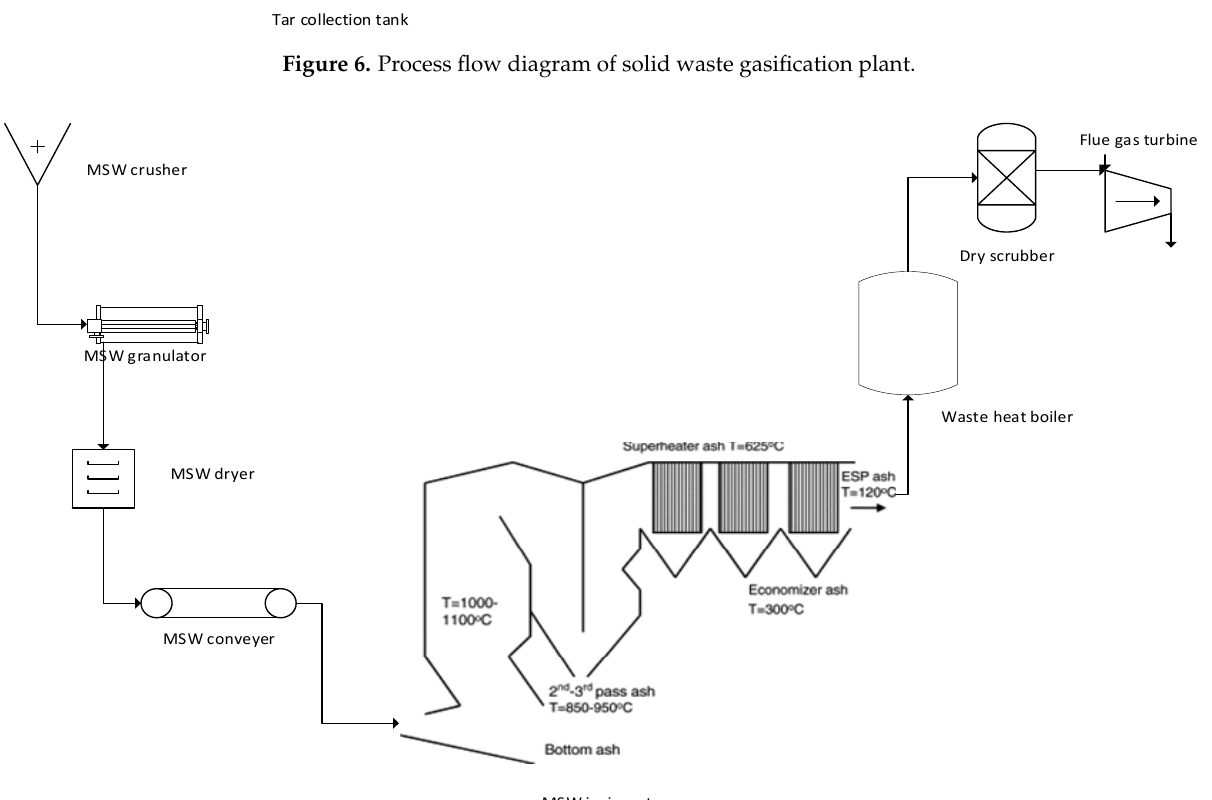
a solid waste landfilling chemical plant is shown below in Figure 8.